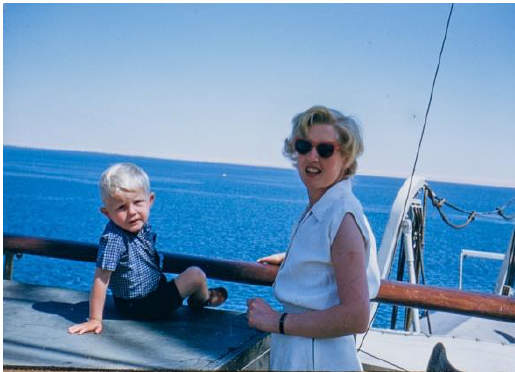
Figure 3. Stephen Wilson and Mrs Wilson aboard the Polish ship Batory en route to India.